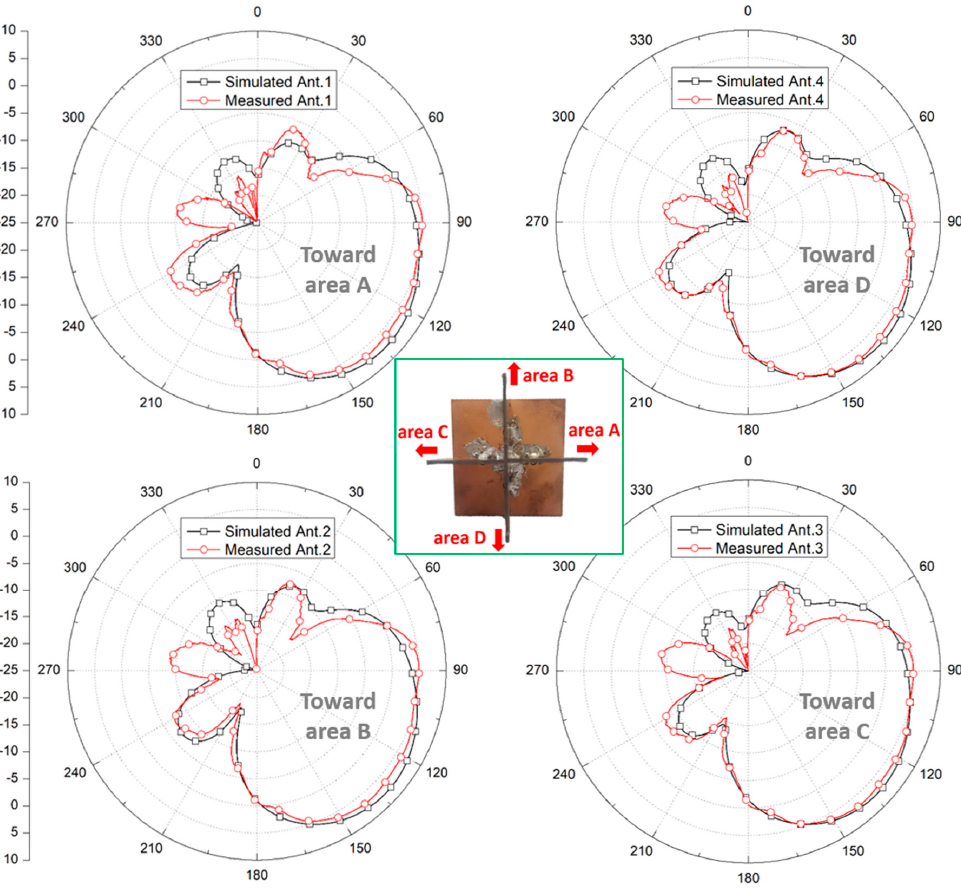
Figure 10. Measured ( a ) return loss and ( b ) isolation characteristics among each antenna port.